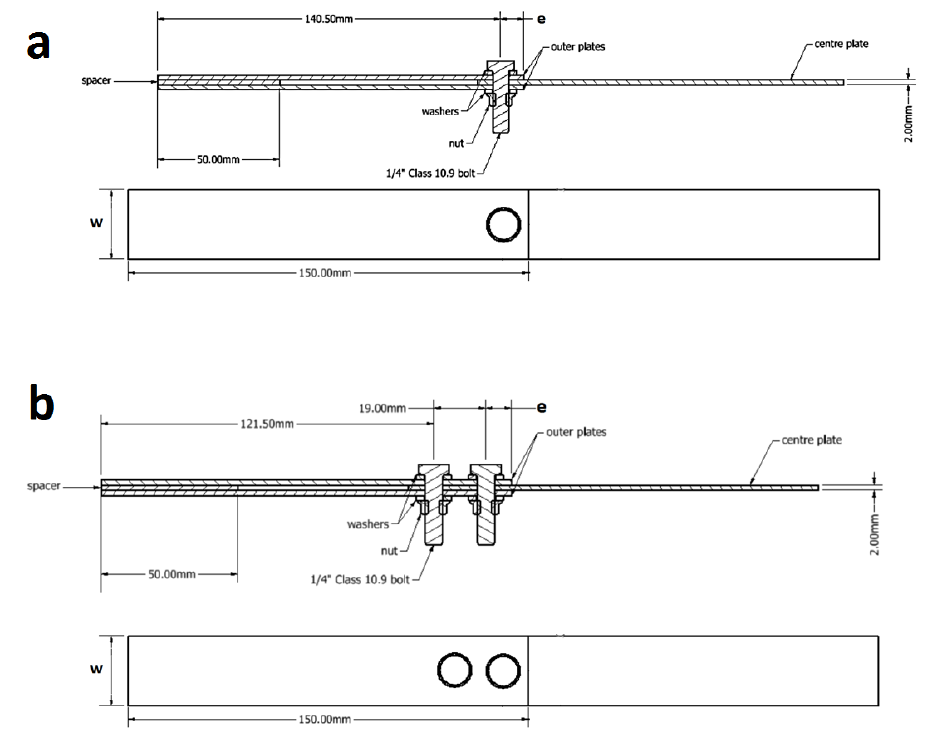
Figure 1. Bolted joint specimens: ( a ) single bolt joint; and ( b ) double bolt